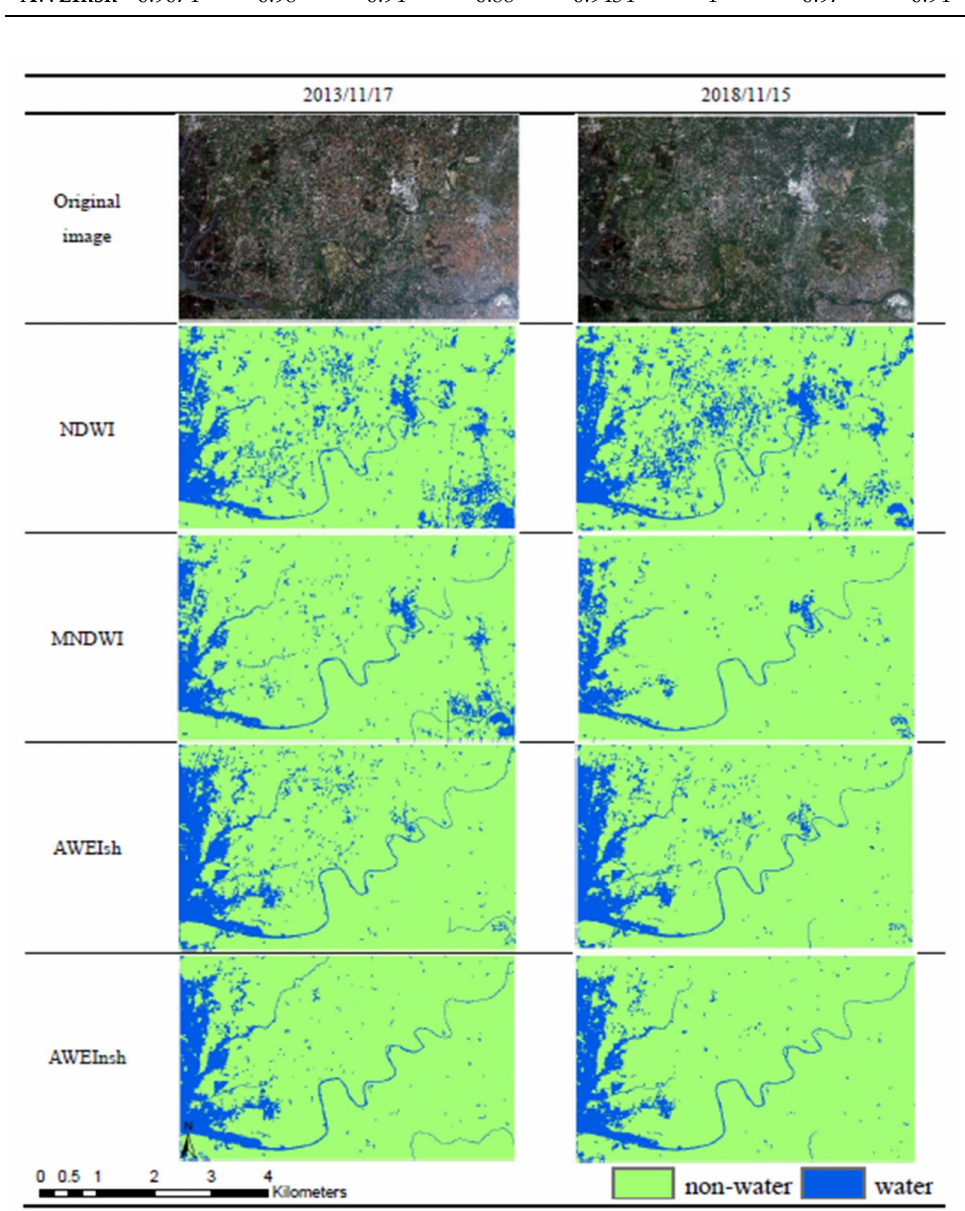
Figure 5. Beigang River: Results of spectral water body indices in terms of water body extraction at different